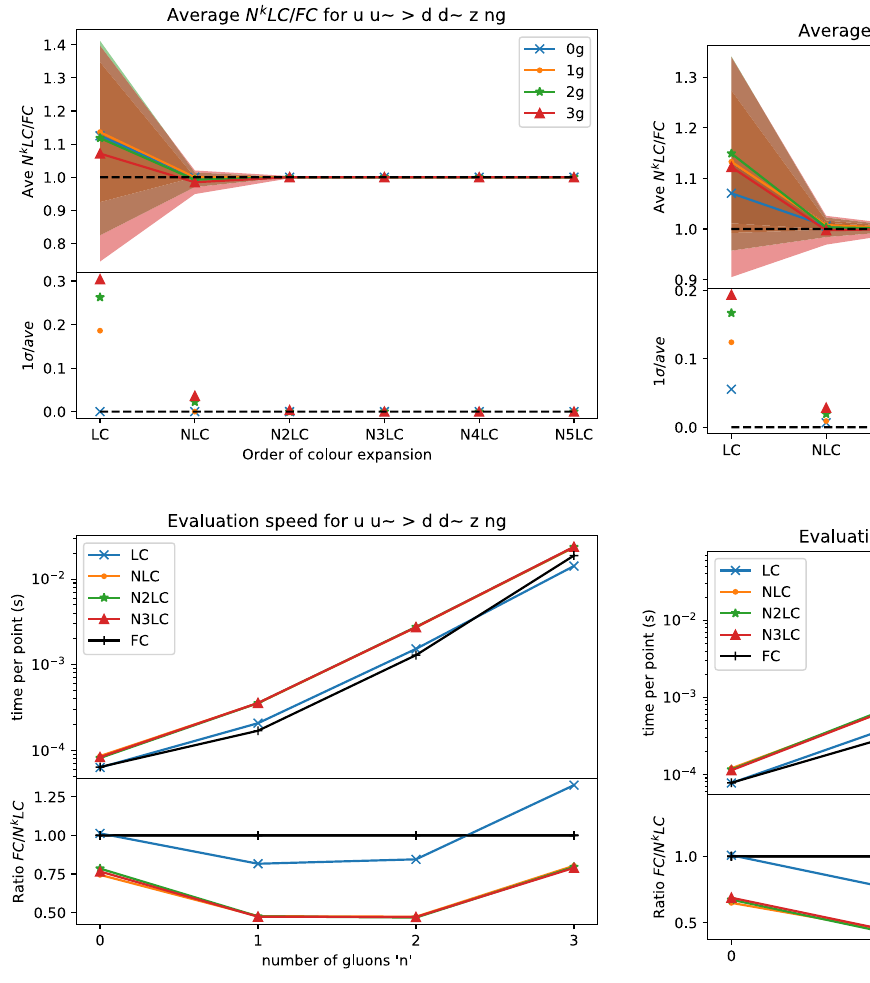
Fig. 15 Same as Figs. 3 and 10 but for u ¯ u → Z + ng